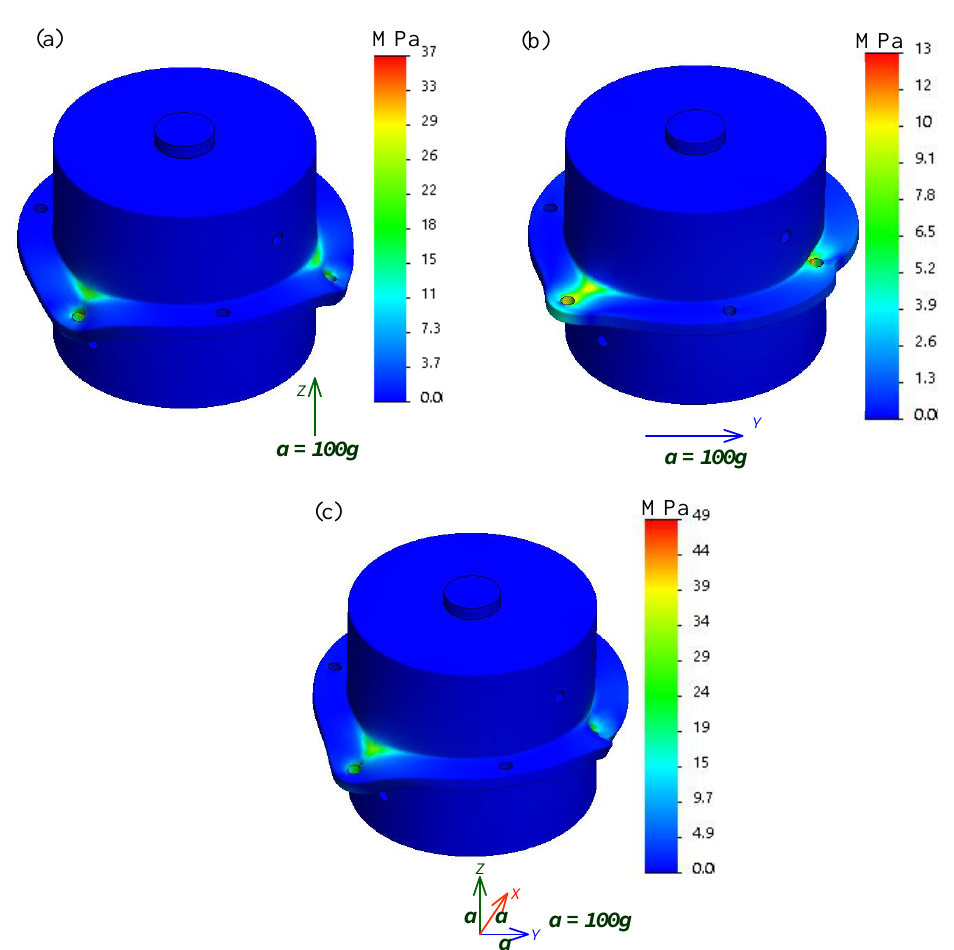
Figure 2. Deformation and von Mises stress of the USOC (Ref. [19]) loaded by the 100 g shock acceleration along different directions: ( a ) Vertical direction ( Z -axis). ( b ) Horizontal direction ( Y -axis). ( c ) Three orthogonal directions ( X -axis, Y -axis, and Z -axis) (the deformation has been amplified by a factor of 5 × 10 3 for